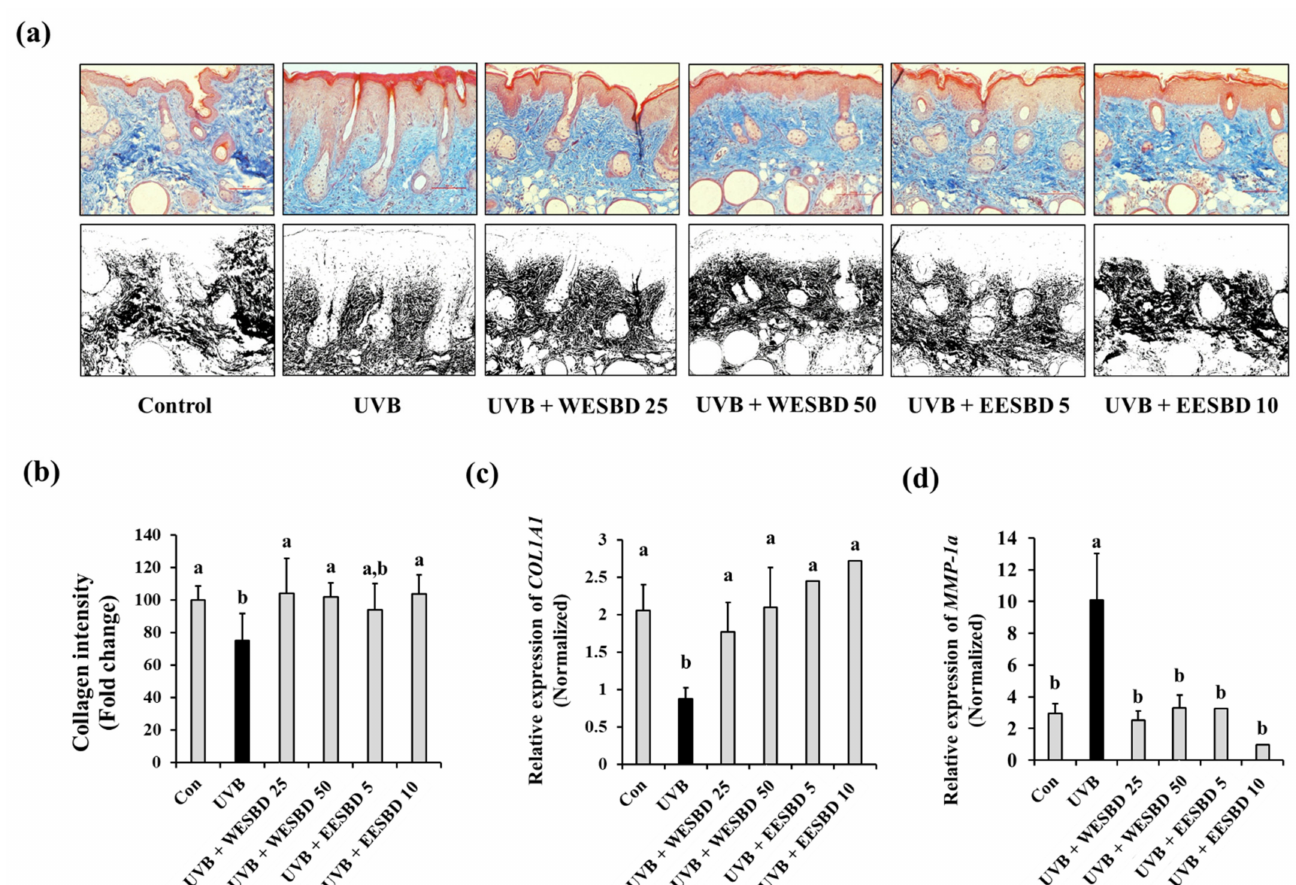
Figure 5. The change in the collagen contents of ultraviolet B (UVB)-irradiated mouse skin was recovered by topical administration of water extract of S. barbata D. Don (WESBD) or ethanol extract of SBD (EESBD). The tissue collagen content was visualized by Masson’s trichrome staining ( a ), upper panel) ( n = 7). Only collagen-positive signals (blue) were converted to back color ( a , lower panel) and the intensity of each black signal was calculated by using the ImageJ program and tabulated ( b ). The expression of type-1 procollagen ( COL1A1 ) ( c ) and metalloproteinase-1a ( MMP-1a ) ( d ) in each mouse group ( n = 7) was determined using quantitative real-time PCR (qRT-PCR) and normalized to that of the glyceraldehyde 3-phosphate dehydrogenase ( GAPDH ) gene. Data are presented as the mean ± SD. Different letters indicate a significant difference between groups ( p <